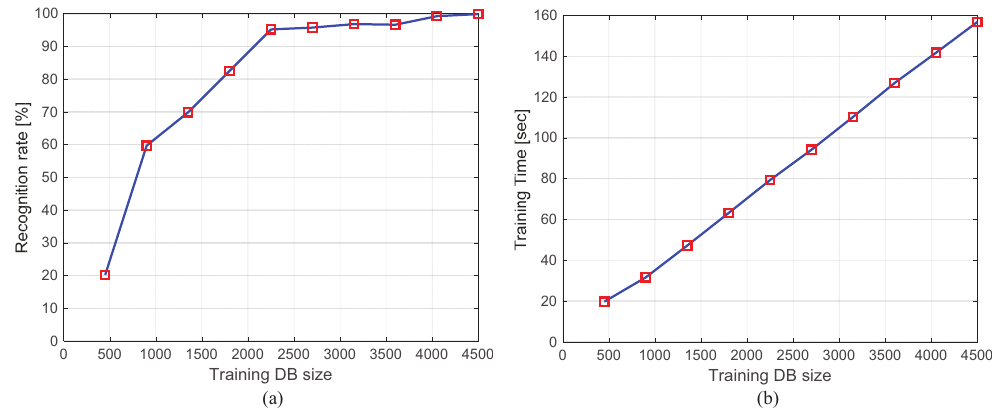
Figure 13. Training parameter analysis: ( a ) recognition rate vs. training DB size; ( b ) training time vs. training DB size.